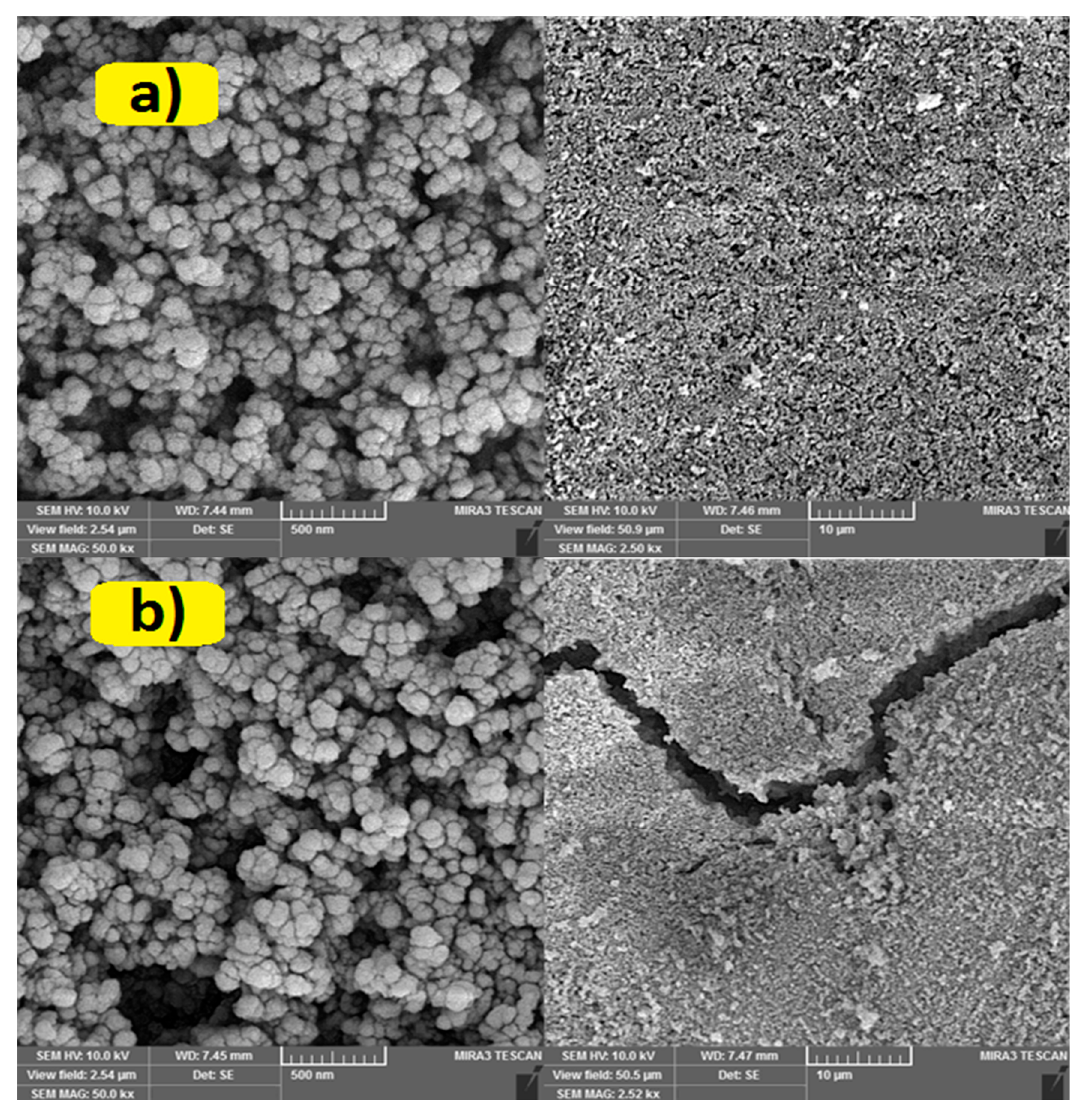
Figure 2. SEM images of I-TiO 2 ( a ) and Ar-TiO 2 ( b ) samples at 2.52 kx (left) and 50 kx (right) magnifications.